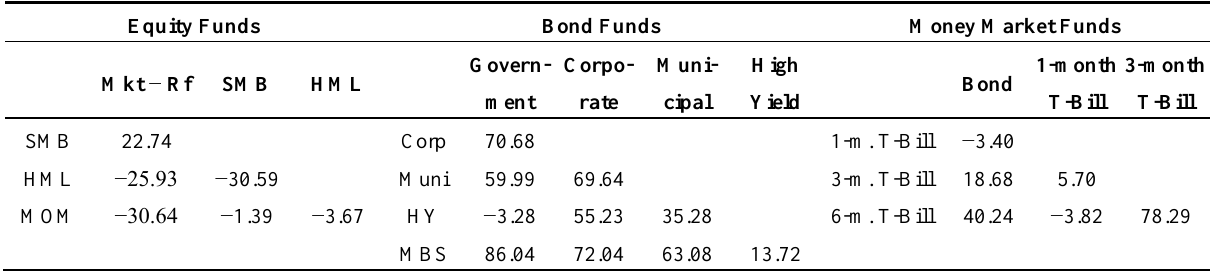
Table 1 . Correlations between factors and indices for multi-factor